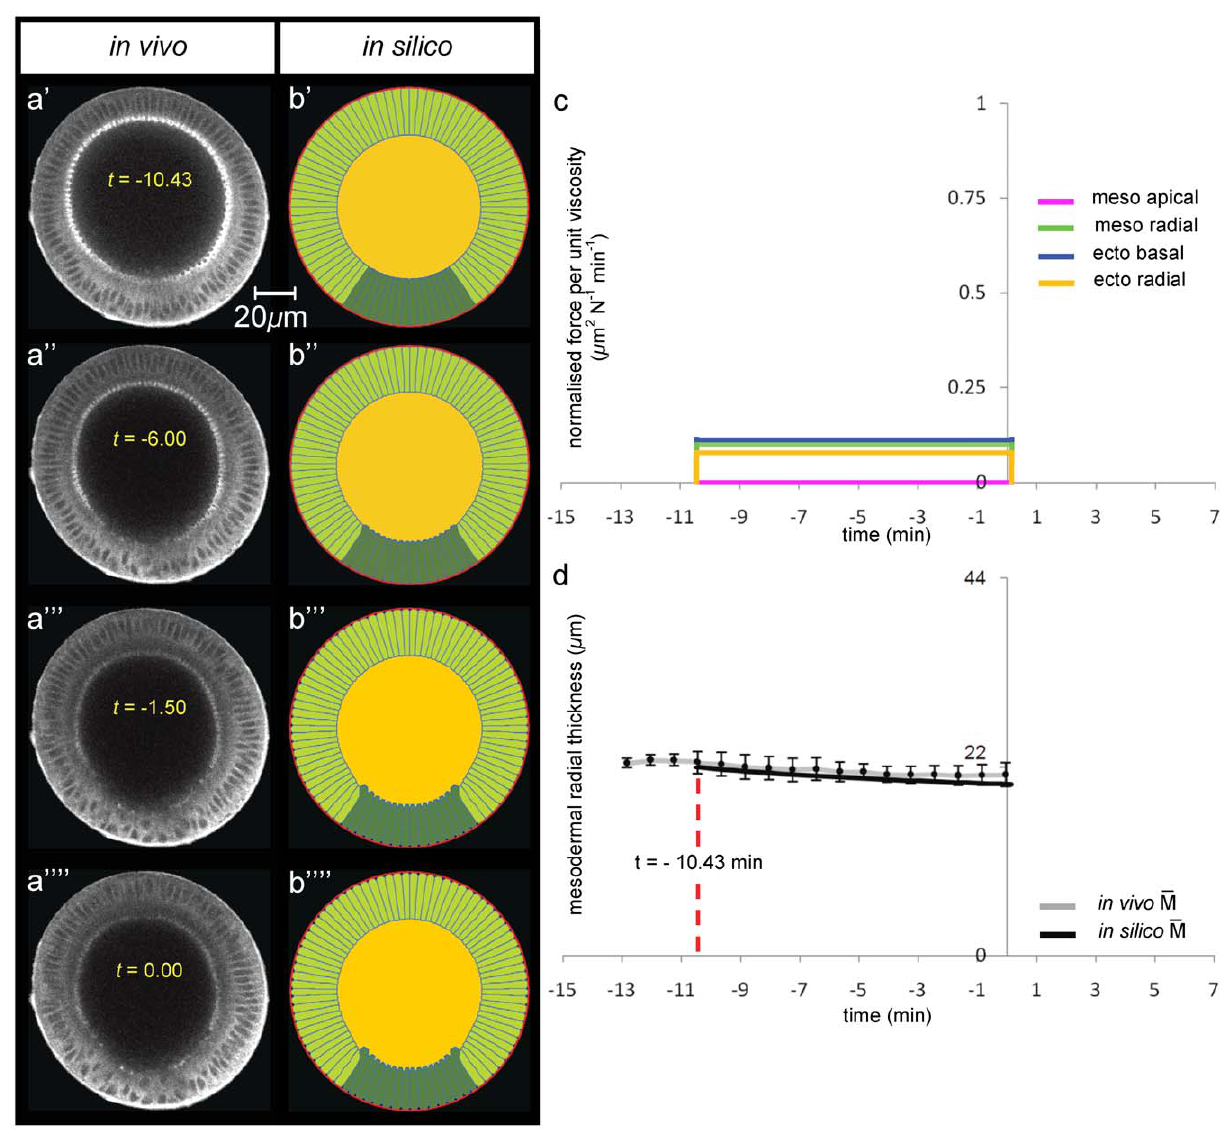
Figure 6. Modelling ventral furrow invagination: cta/t48 -mutant genotype. ( a ) Selected multi-photon images of in vivo transverse cross- sections of a cta/t48 -mutant embryo during ventral furrow formation. In cta/t48 -mutants apical constriction is completely abolished. Embryo is labelled with Sqh-GFP and oriented with its dorsal surface upward (Fig. 1a). Time interval between successive frames is 45 sec and instant zero was set by using apical-basal cell height profiles on the dorsal side (Fig. S2d). ( b ) Selected frames (columns) of in silico transverse cross-section of a cta/t48 - mutants genotype. Embryo’s 2D geometry is oriented with its dorsal side upward. The undeformed initial configuration (panel b 9 ) corresponds to in vivo deformations at t= 2 10.43 min (see panel d). ( c ) In silico force distributions utilised to simulate invagination in b). ( d ) Time-trends of average radial mesodermal ( (cid:2) MM ) thickness of the epithelium (see schematic in Fig. 3e).